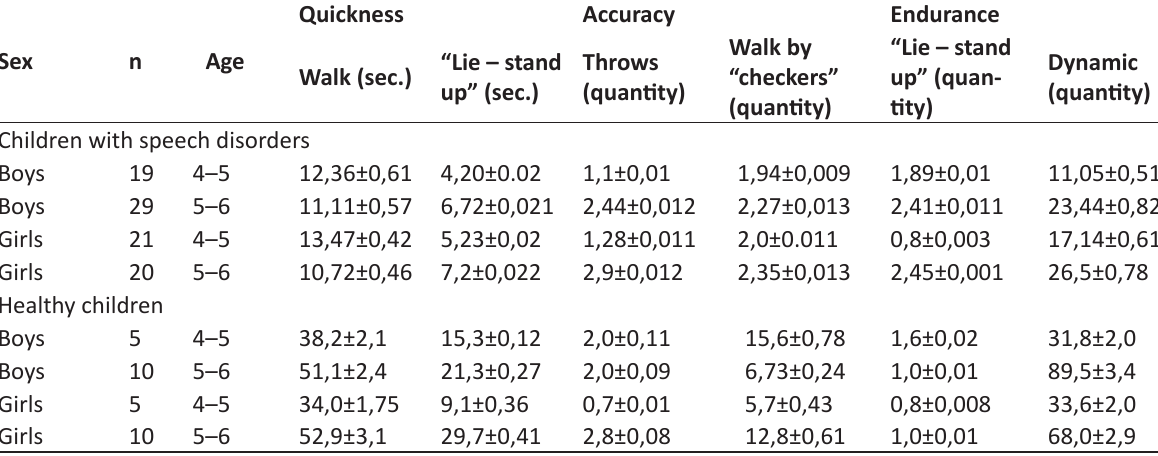
Table 1. Psycho-physical characteristics of 4-6 yrs